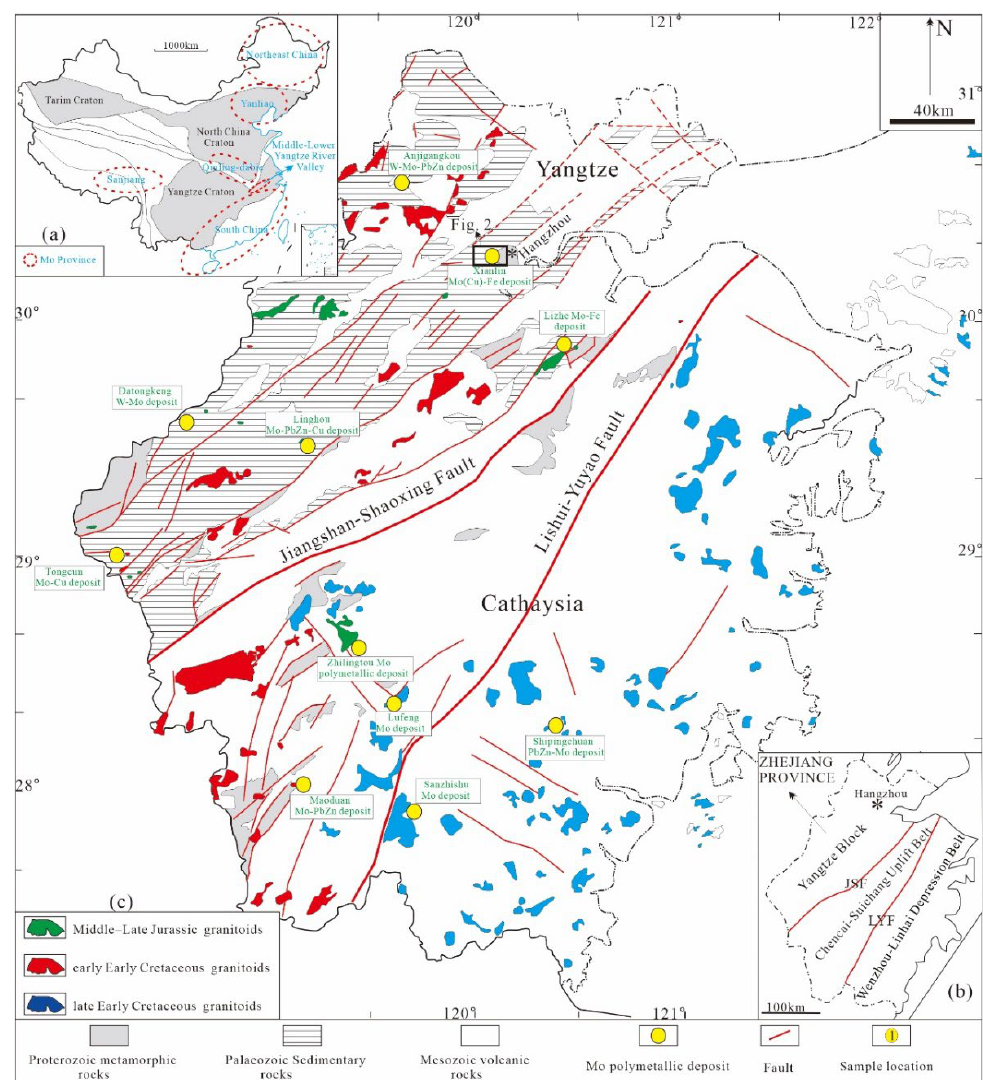
Figure 1. ( a ) distribution map of Mo metallogenic province in China [10]; ( b ) regional tectonic map of Zhejiang Province [26]; ( c ) simplified geological map of Zhejiang Province, showing the distribution of Mo polymetallic deposits [19,24].